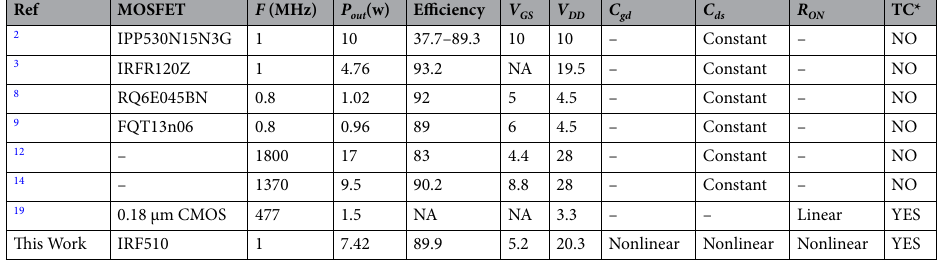
Table 6. The comparison between the presented inverter and other works. *TC refers to thermal